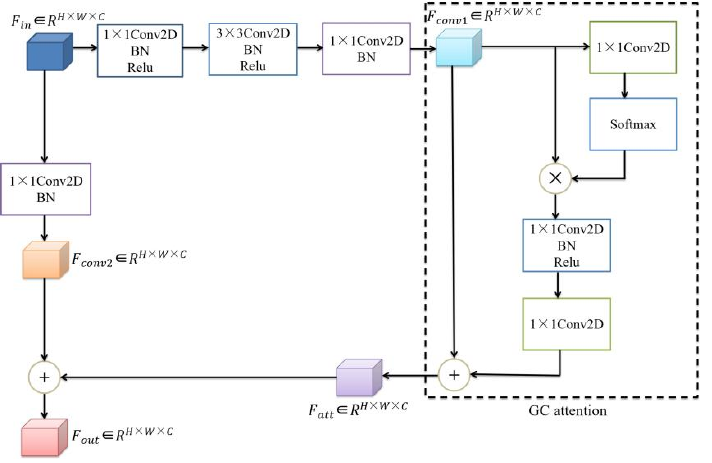
Figure 6. The structure of the RA block.